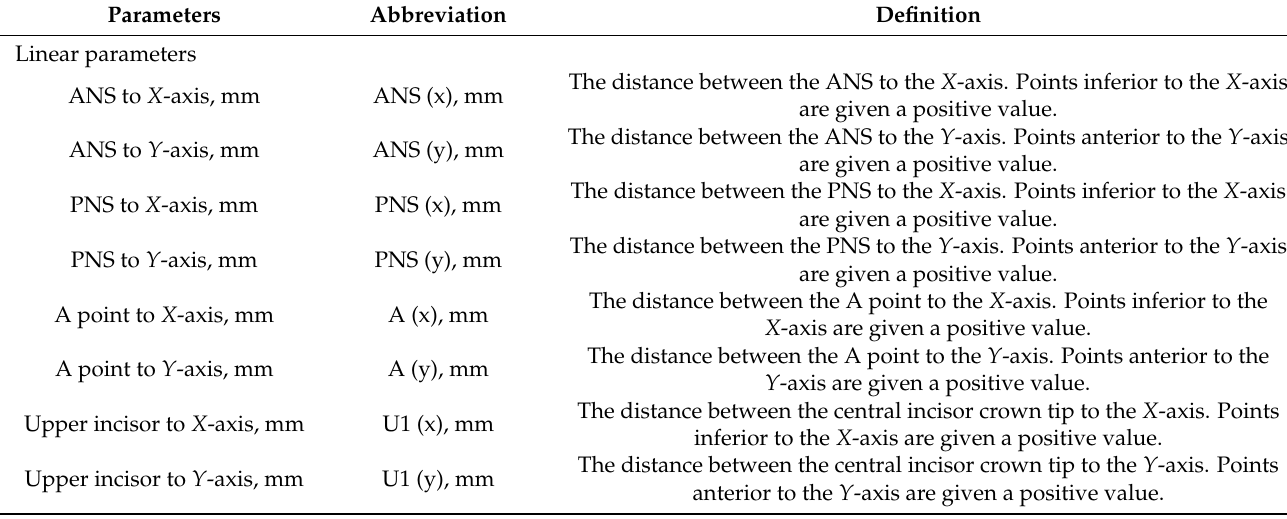
Table 1. Definition of the distance from the landmarks to the X-, Y